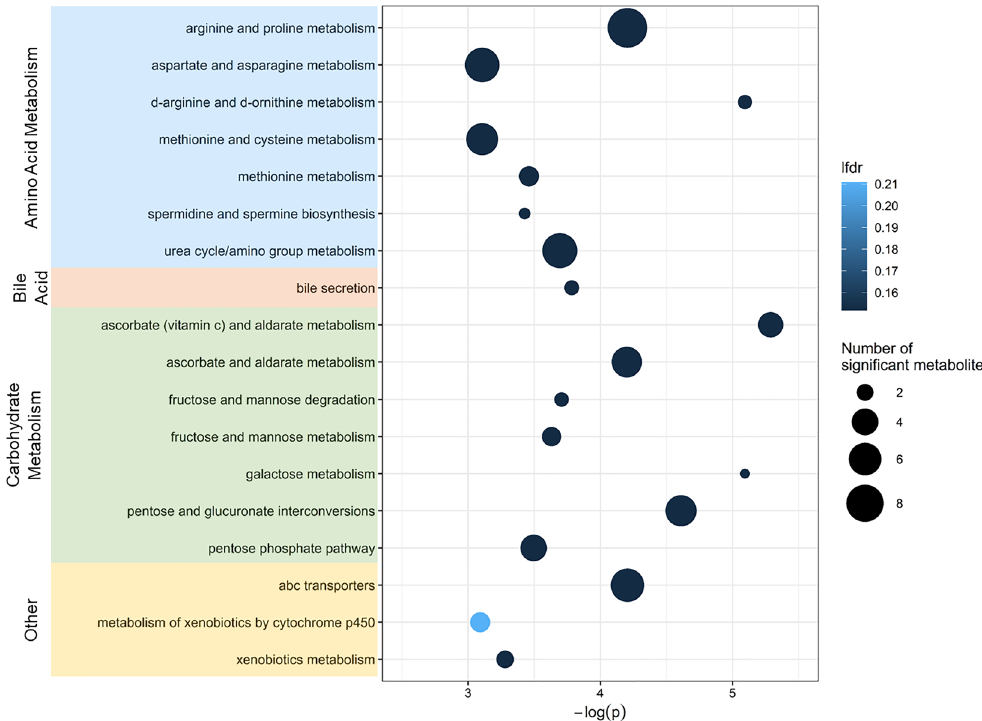
Figure 6. Overview of enriched pathways by confirmed HILIC and C18 chromatography column metabolites that were significantly associated with infant age, identified using Metapone. Pathways with P ≥ 0.05 and weighted number of significant metabolites ≥ 1.5 are included. Point size indicates the number of significant metabolites identified within each pathway and point color indicates significance after adjustment for multiple testing via conditional local false discovery rate (lfdr). Pathways are grouped by super pathway (amino acid metabolism, bile acid, carbohydrate metabolism, lipid, and other), indicated by